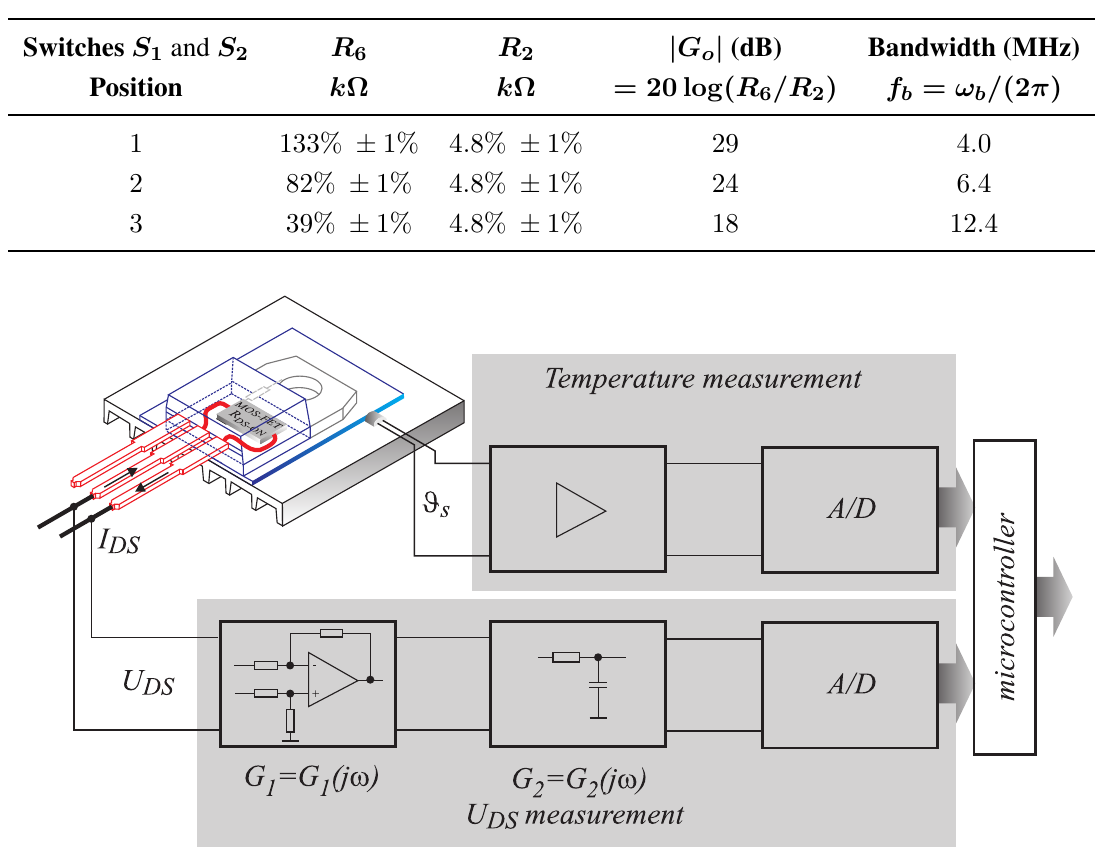
Figure 10. Block scheme of voltage U